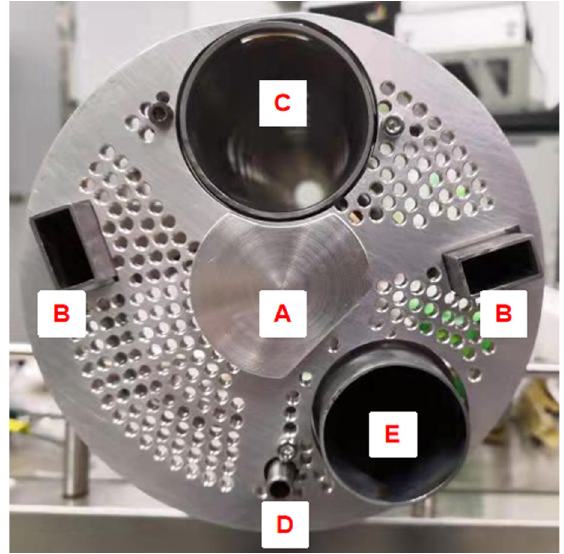
FIG. 3. Plasma chamber injection system of SECRAL-II ion source. The biased disc (A) is at the center, surrounded on both sides by two WR62 type rectangular waveguides (B). The oven port (C) is at the top and the gas inlet (D) is at the bottom. The circular waveguide is located in place (E).